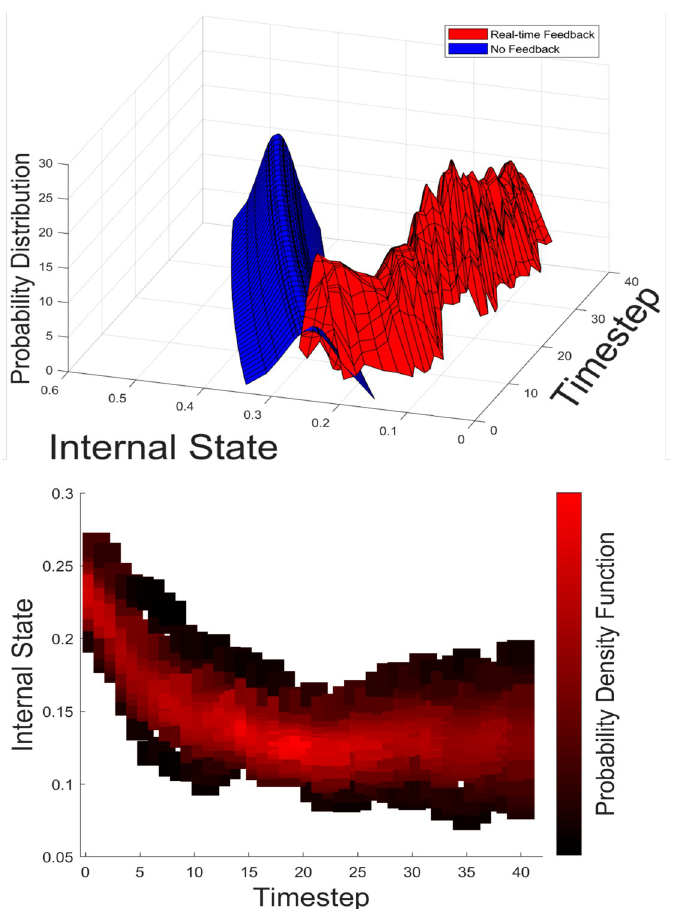
Fig 5. Probability distribution of worker’s internal state (N = 20). (Top) Probability distribution of workers’ internal states over time in a colony of 20 workers with (red) and without (blue) real-time feedback. We compared the results of simulations with real-time feedback and with a no-feedback case to study how queen patrol behaviour suppresses the internal state of workers. No feedback (blue) causes continuous growth of the internal states regardless of the colony size. With real-time feedback in relatively small colonies, the average value of the workers’ internal states decreases from 0.2361 to 0.1344. (Bottom) This can be seen more clearly in the bottom plot, with the decrease in the internal state of workers from the initial value. The intensity of the colour shows the probability density function, with a larger proportion of workers being close to the mean. The shift of the distribution for real-time feedback demonstrates that the patrol behaviour is successful in suppressing the internal states of